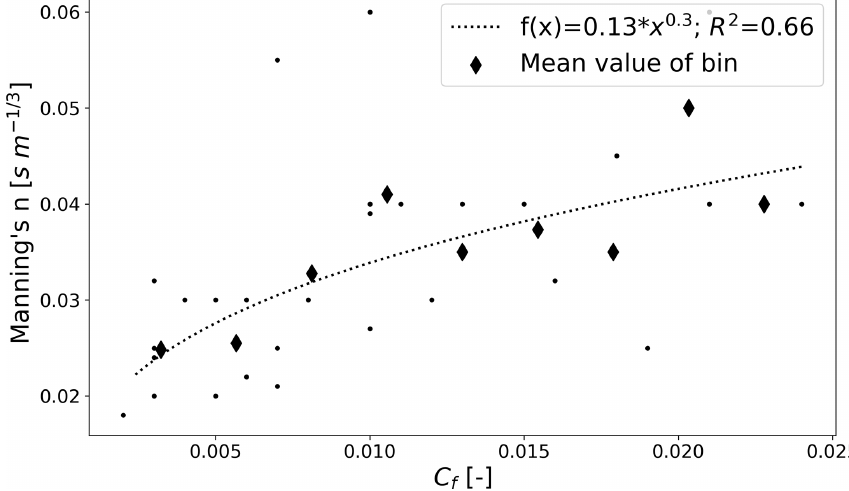
Figure B2. Calibrated flow accumulation C f vs. Manning’s n .